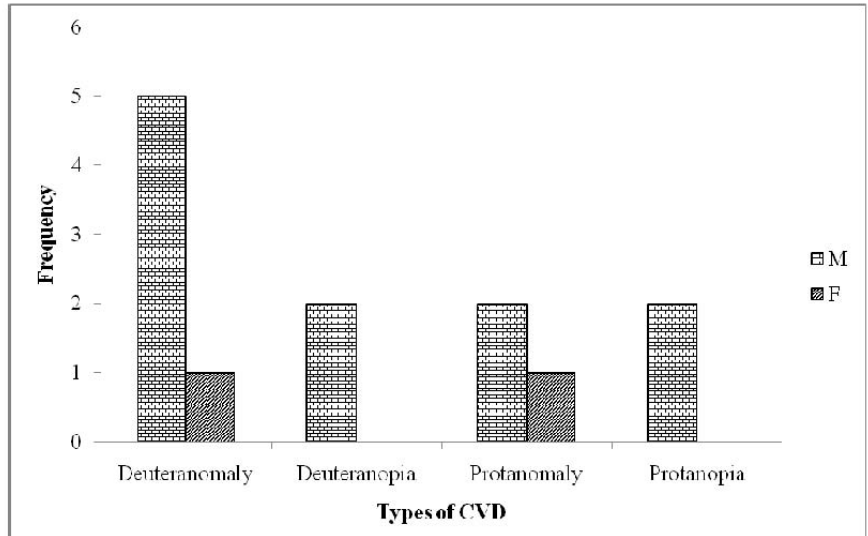
Figure 1 Relative comparison between the CVD type in terms of gender distribution (M and F represent male and females, respec - tively on the graph) Table 1 Types of CVD, Dominant eye, Chromagen lens tint chosen by the subject, and Colour perception level before and